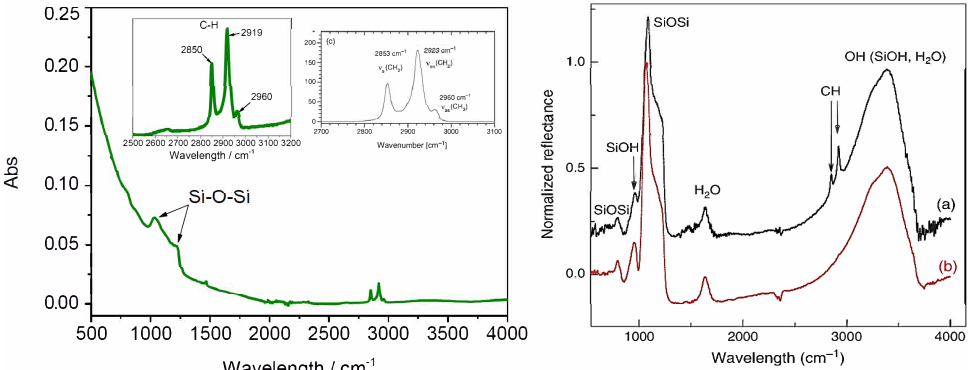
Figure 6. ( a ) Infrared spectrum of an octadecyl-functionalized silicon nanowire; C-H region enlarged, upper right ; C-H stretching vibration of OTS according to Figure 1C of [23] (inset, upper left ); ( b ) organosilica films stretching vibration before ( b ) and after ( a ) alkyl groups grafting as shown in Figure 3 from [24].